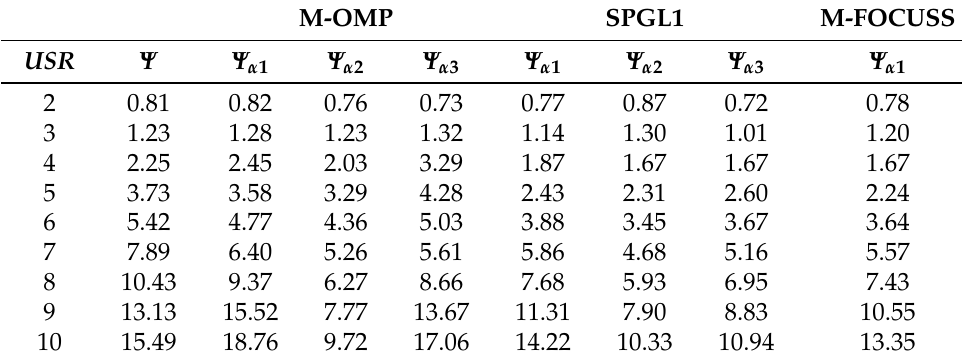
Table 5. Comparison of PRD values from the algorithms using the three dictionary matrices at several USR values, for ECG signal No. 107.